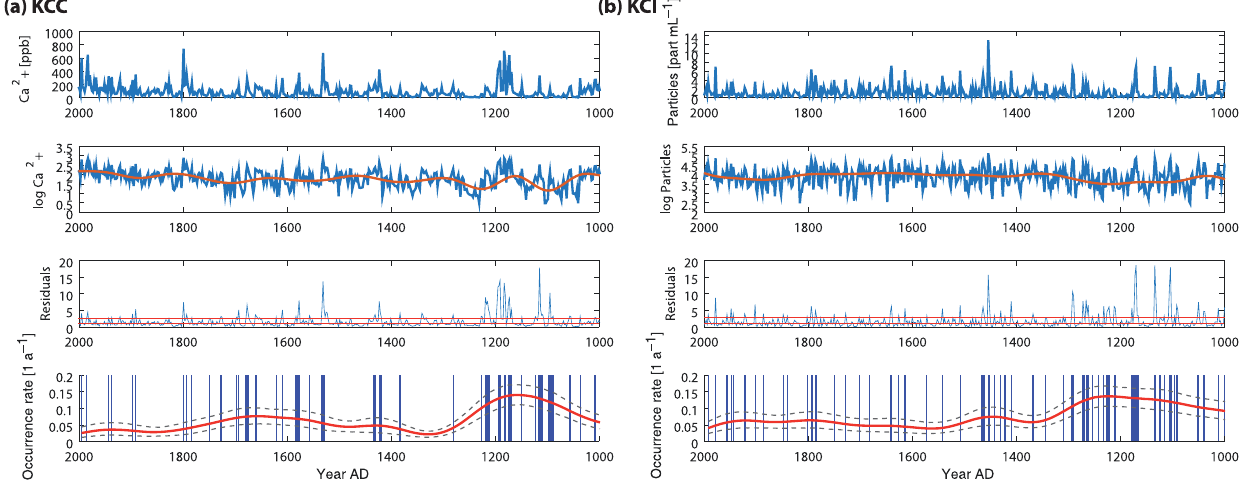
Figure 9. Results from detecting Saharan dust events in the ice core records and estimating their long-term frequency of occurrence: (a) corresponds to KCC and (b) to KCI (see text). The bottom row shows the detected events (blue) and the frequency of occurrence kernel estimate with a 51-year bandwidth (bottom rows, in red) together with 90% confidence